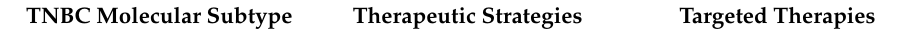
Table 2. Cont. TNBC Molecular Subtype Therapeutic Strategies Targeted